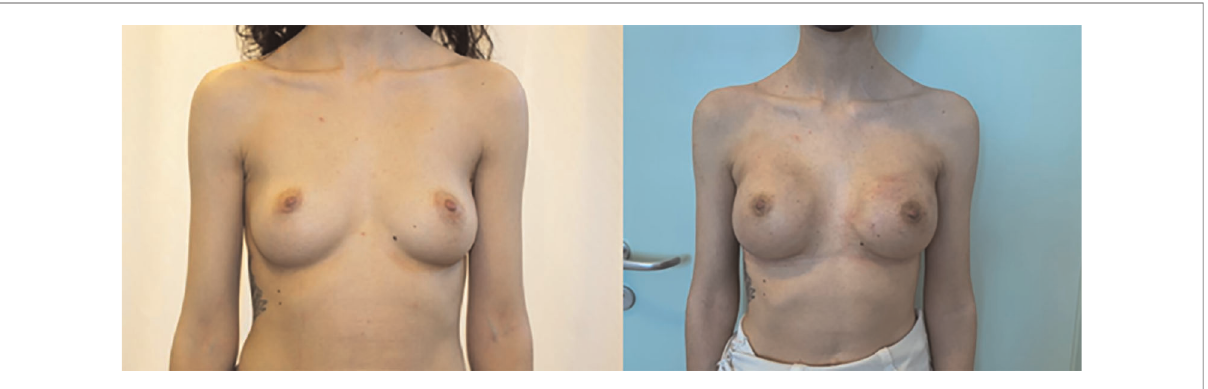
FIGURE 3 IBR with prepectoral implantation and ADM Fortiva®, preceded by bilateral nipple-sparing mastectomy. Pre- (left) and post-operative photos